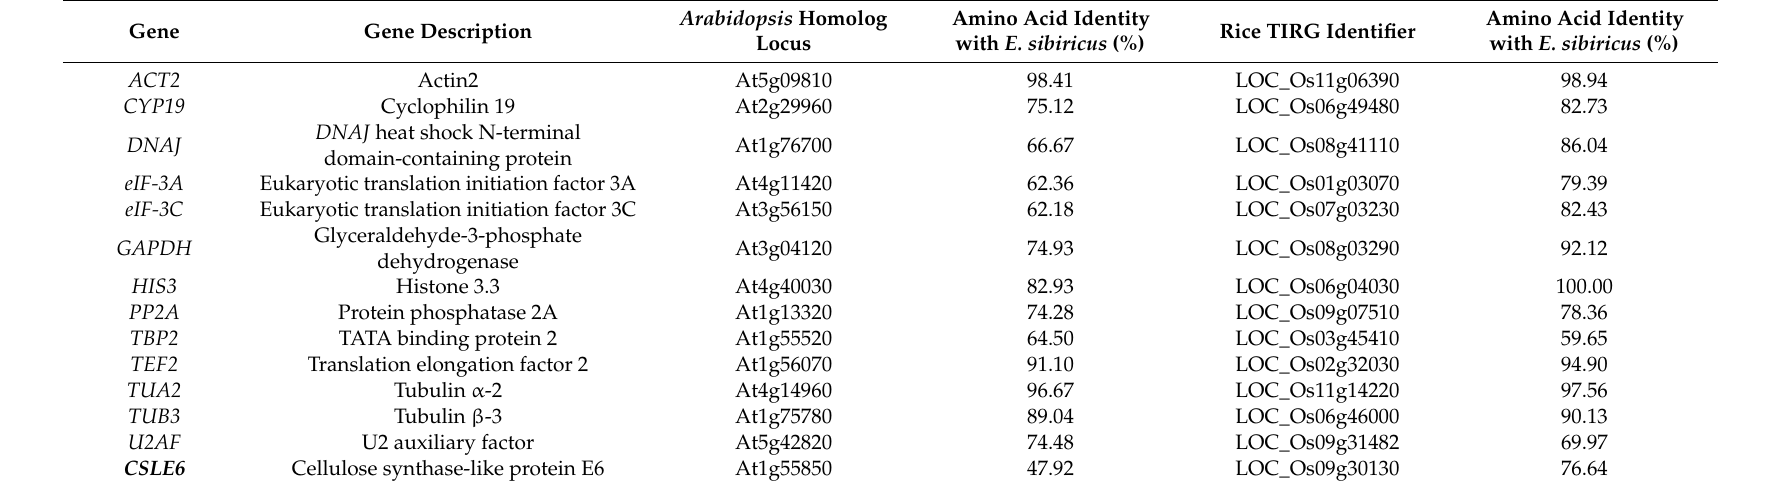
Table 2. Description of 13 reference genes and one target